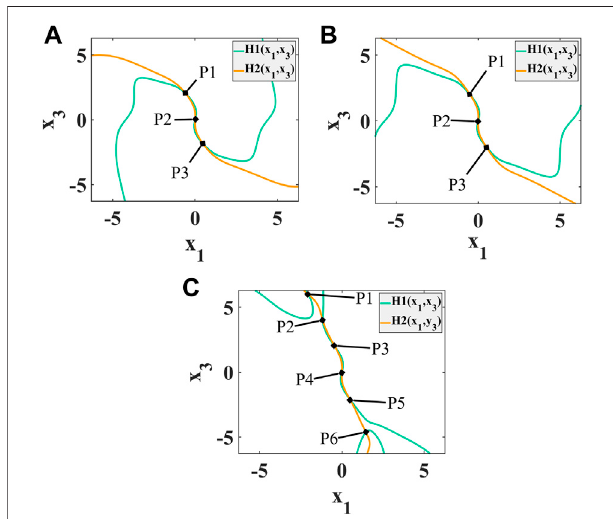
FIGURE 3 | Trajectory diagram of H1 and H2 (A) when the memristor coupling strength k is − 0.08; (B) when the memristor coupling strength k is 0; (C) when the memristor coupling strength k is 0.08.